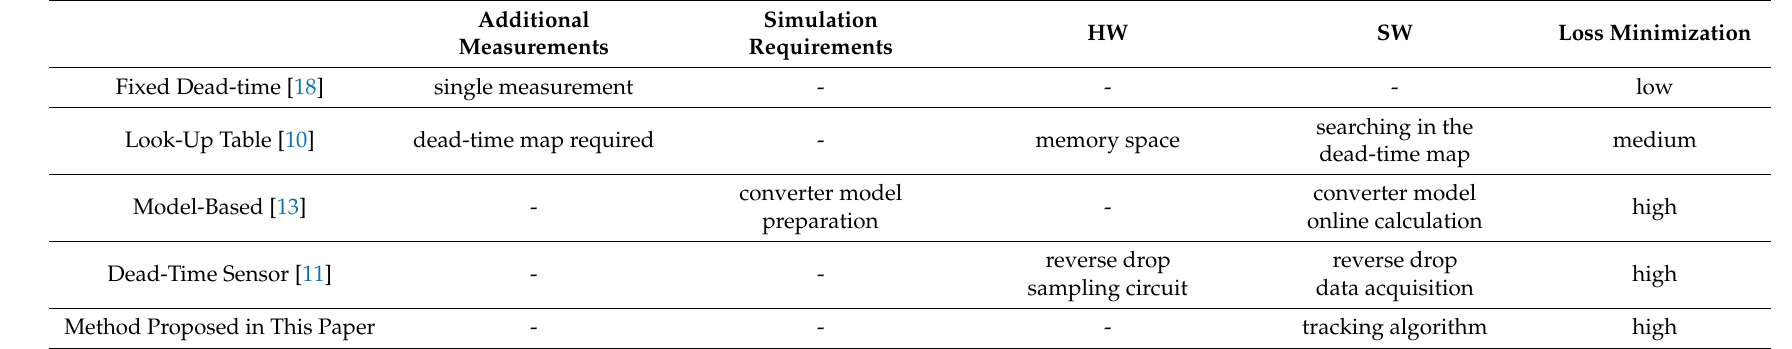
Table 4. Dead-time optimization method